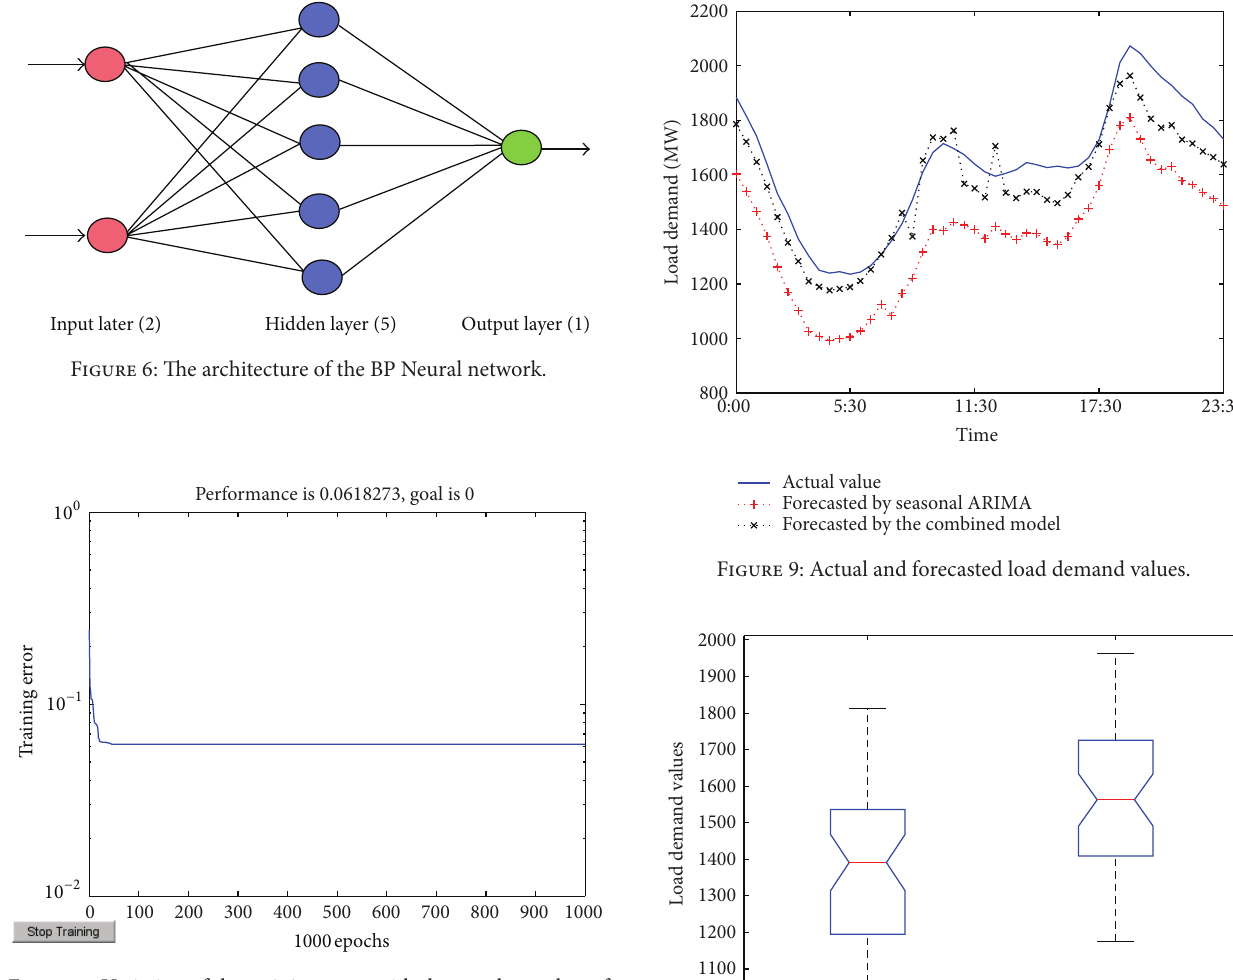
Figure 7: Variation of the training error with the epoch number of the BP neural network.